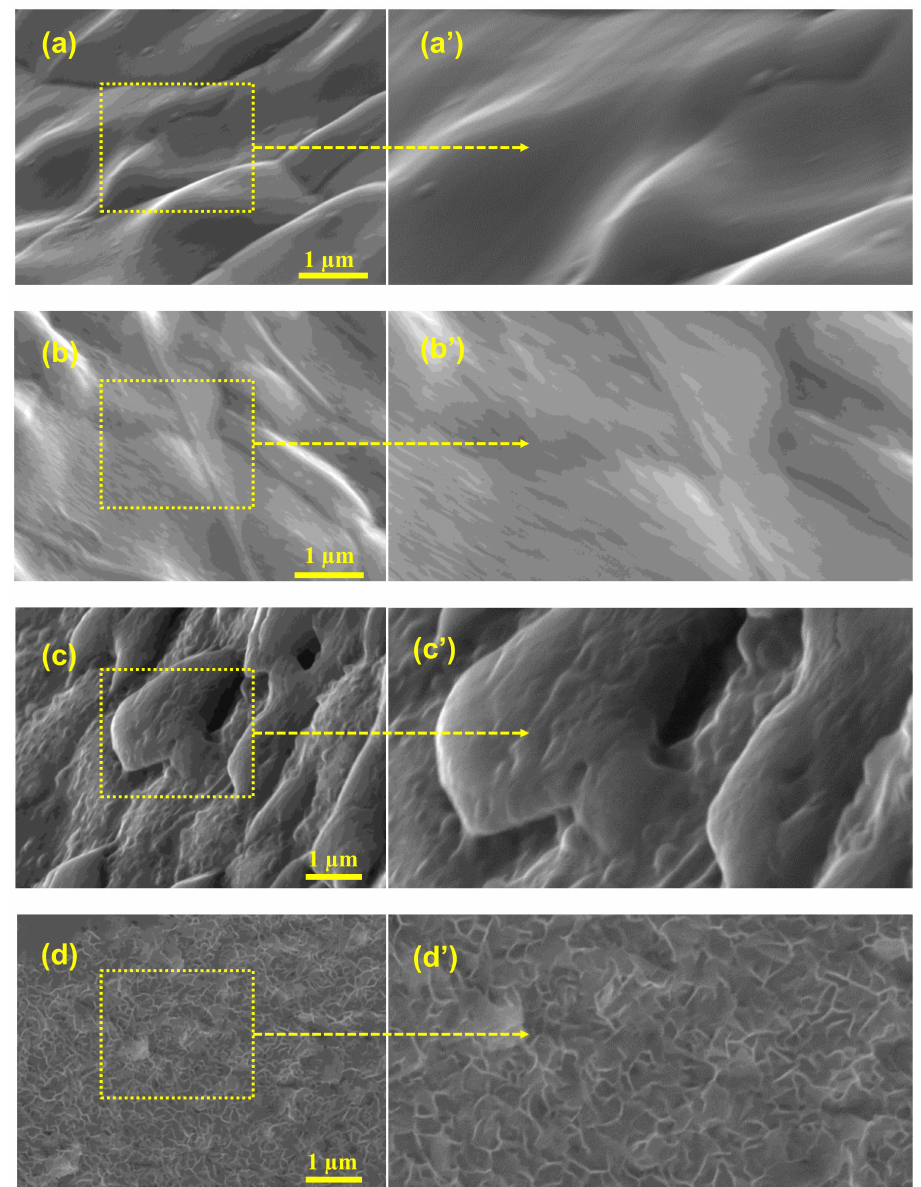
Figure 2. ( a , a’ ) Closed inspection analysis of the SEM image of the Ni-foam; ( b , b’ ) closed inspection analysis of the SEM image of the Ni-foam washed with ethanol; ( c , c’ ) closed inspection analysis of the SEM image of the Ni-foam washed with 1M HCl solution; and ( d , d’ ) closed inspection analysis of the SEM image of the Ni-foam washed with 3M HCl